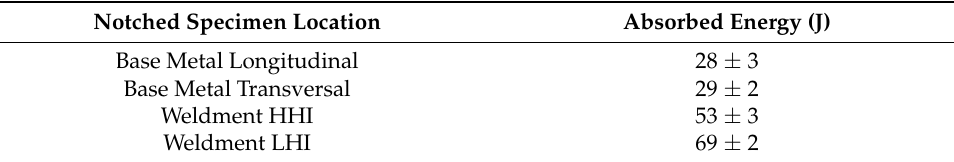
Table 3. Charpy absorbed energy.